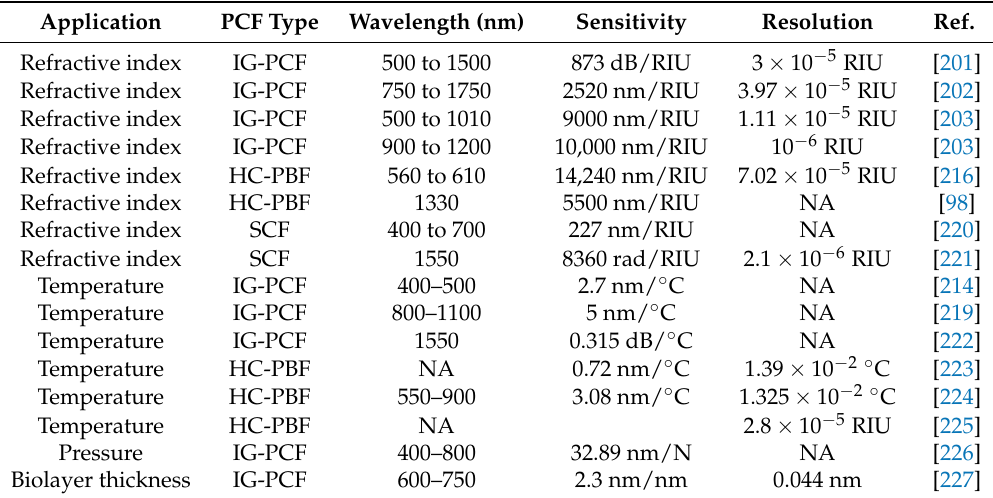
Table 5. Properties of most relevant plasmonic PCF